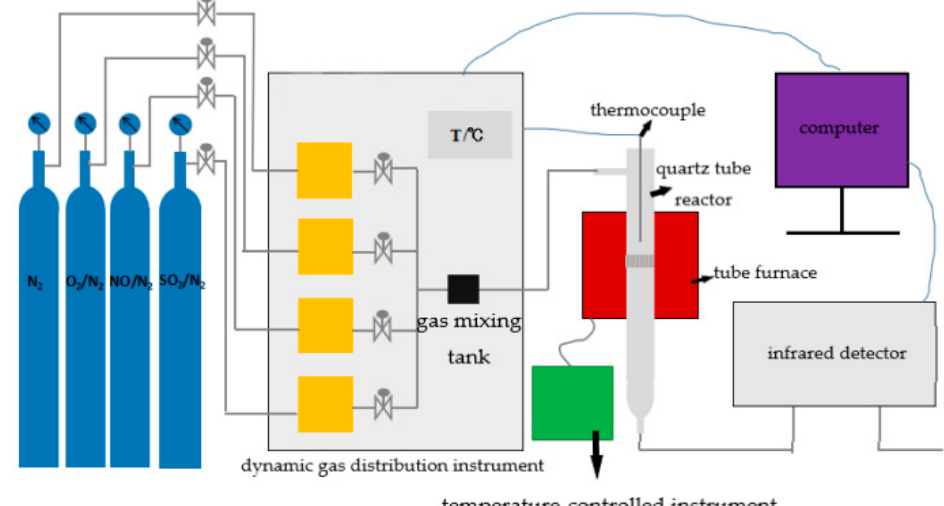
Figure 1. Simultaneous reaction and test device for desulfurization and denitrification.